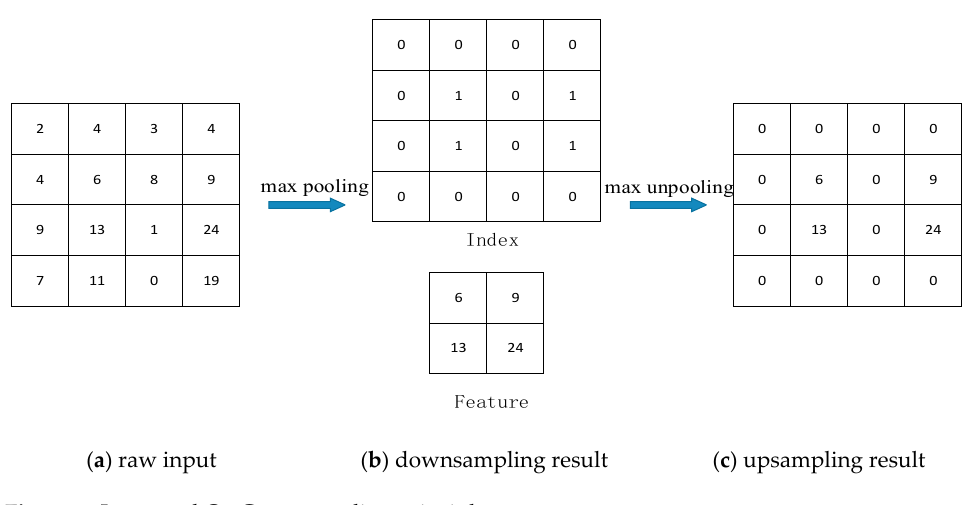
Figure 8. Improved OctConv sampling